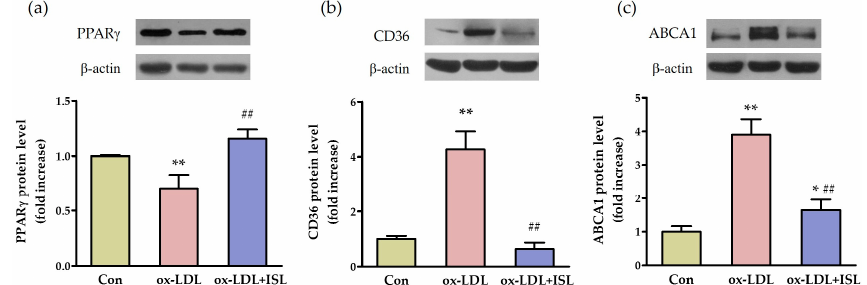
Figure 2. ISL affects expression of cholesterol-metabolism-related genes in macrophages induced by oxidative low-density lipoprotein (ox-LDL). The protein levels of peroxisome proliferator-activated receptor gamma (PPAR γ ) ( a ); CD36 ( b ); and ABCA1 ( c ) were determined using Western blot